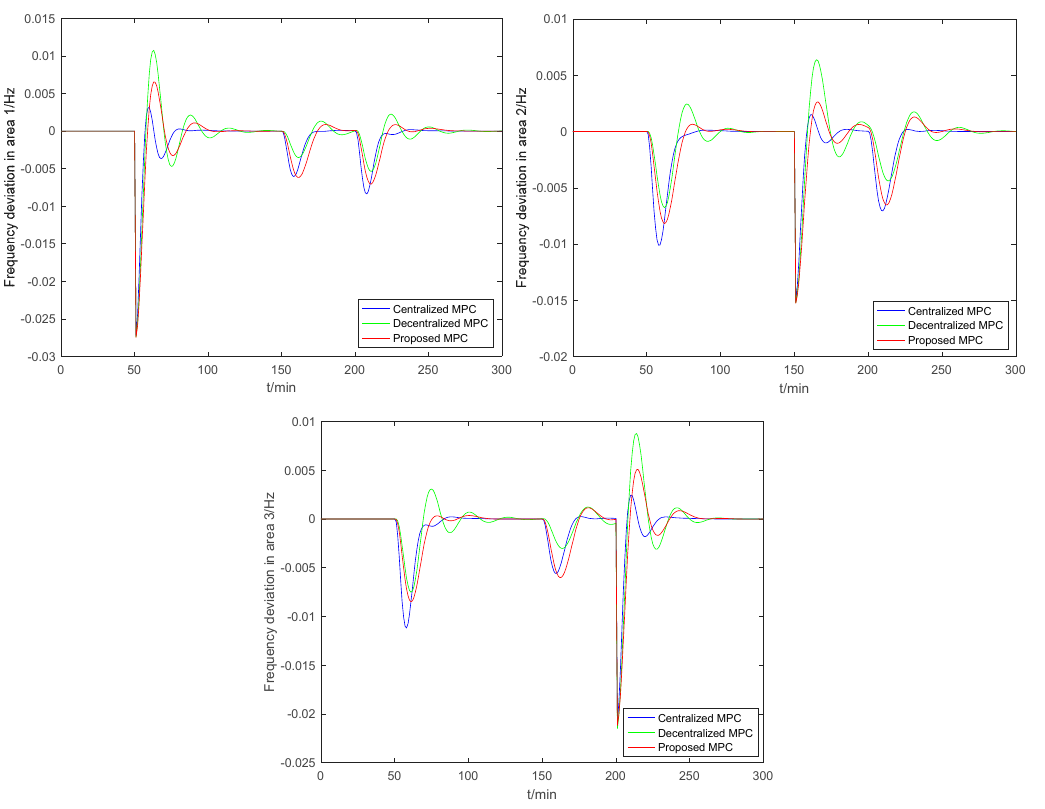
Figure 5. Area frequency deviation curves.